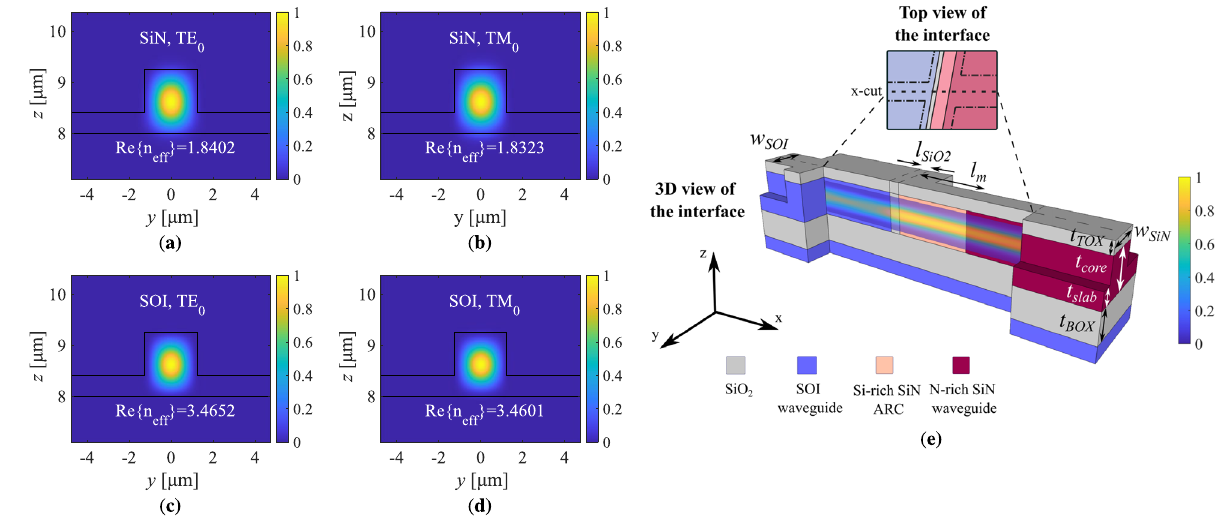
Figure 2. Calculation of the propagation characteristics regarding the fundamental TE and TM modes for the N-rich SiN and SOI waveguides. The distribution of the electric field at the cross-sections of the waveguides is calculated through the 2D-FDE method for the cases of (a) the TE 0 mode supported by the N-rich SiN waveguide, (b) the TM 0 mode supported by the N-rich SiN waveguide, (c) the TE 0 mode supported by the SOI waveguide and (d) the TM 0 mode supported by the SOI waveguide. The intensity of the electric field of the TE 0 mode through an x-cut at the centre of the waveguides is calculated through the 3D-FDTD method and is depicted along the 3D waveguide-to-waveguide interface in (e) , while the related geometric variables are noted. The intensity plot is depicted semi-transparently. The T-bar length variables and the top SiO 2 cladding at the areas of the slabs are not drawn for illustration purposes of the interface. The interface top view is provided as part of Fig. 1a, in order to depict the x-cut along the waveguides.